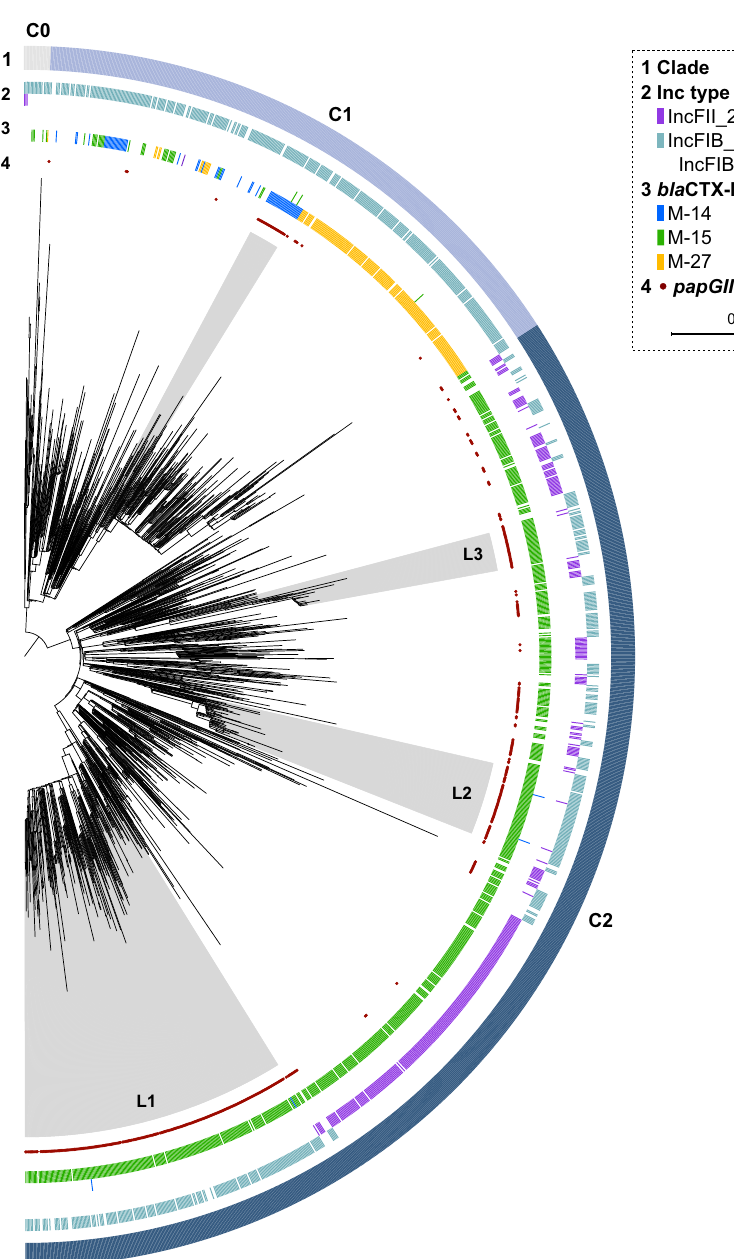
Fig. 1 Phylogenetic tree of ST131 clade C. Maximum-likelihood phylogenetic tree of 1338 clade C0, C1, and C2 isolates based on 10,904 variable sites in a 2.5 Mb core genome alignment. Each isolate is annotated with ST131 subclade af fi liation (ring 1), presence of selected IncF plasmid replicon types (pMLST; ring 2), bla CTX-M allele (ring 3), and papGII gene (ring 4). ST131 papGII -containing sublineages discussed in the text are shaded in grey. Those of clade C2 are annotated with L1, L2, and L3. The scale bar indicates the number of substitutions per site. The tree was visualized using iTOL 74 . Supplementary Fig. 2 shows this tree with additional